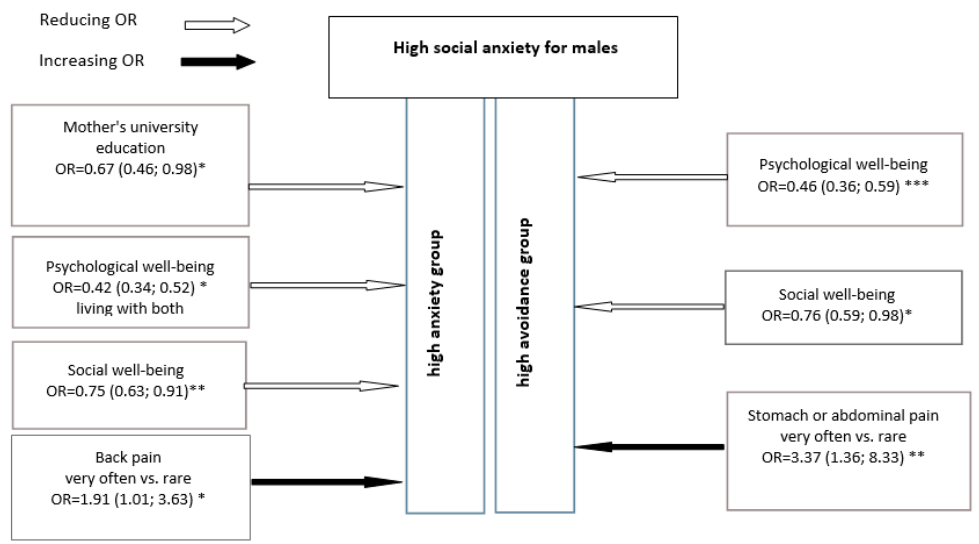
Figure 2. Multivariate logistic regression model for males: opportunity ratio (95% CI) to be high on SA in context of independent variables (* p < 0.05; ** p < 0.01; *** p < 0.001).